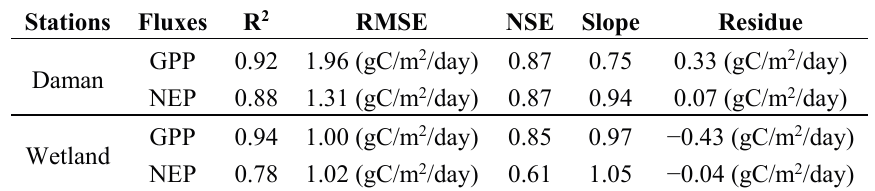
Figure 7. Validation of the NEP estimated by the RS-CFLUX model at the Daman superstation (Daman) and Zhangye wetland station (Wetland). The slope and residual of the linear fit are shown in Table 3. Table 3. Comparison of the RS-CFLUX modeled GPP with the observed GPP at the Daman superstation (Daman) and Zhangye wetland station